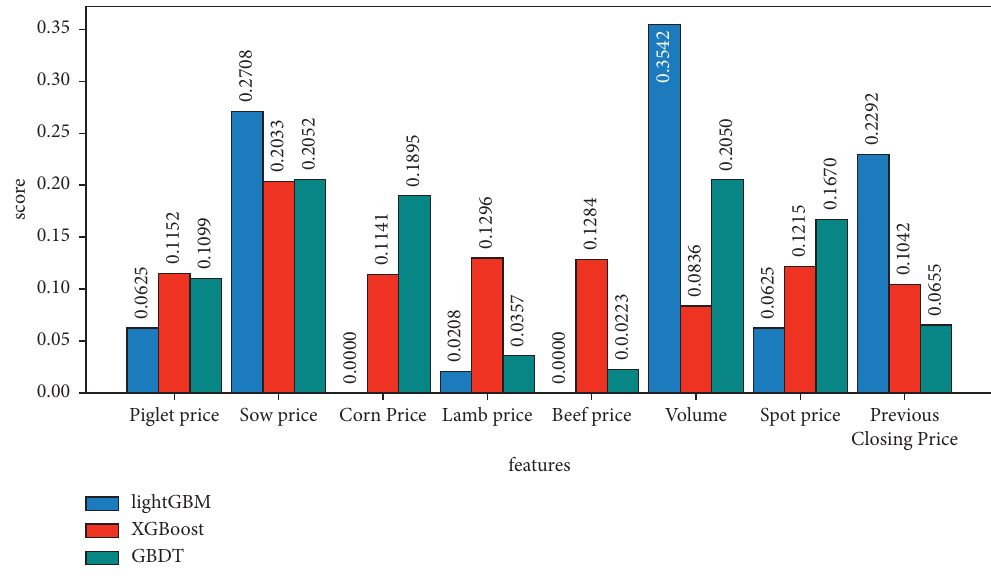
Figure 7: Histogram of feature